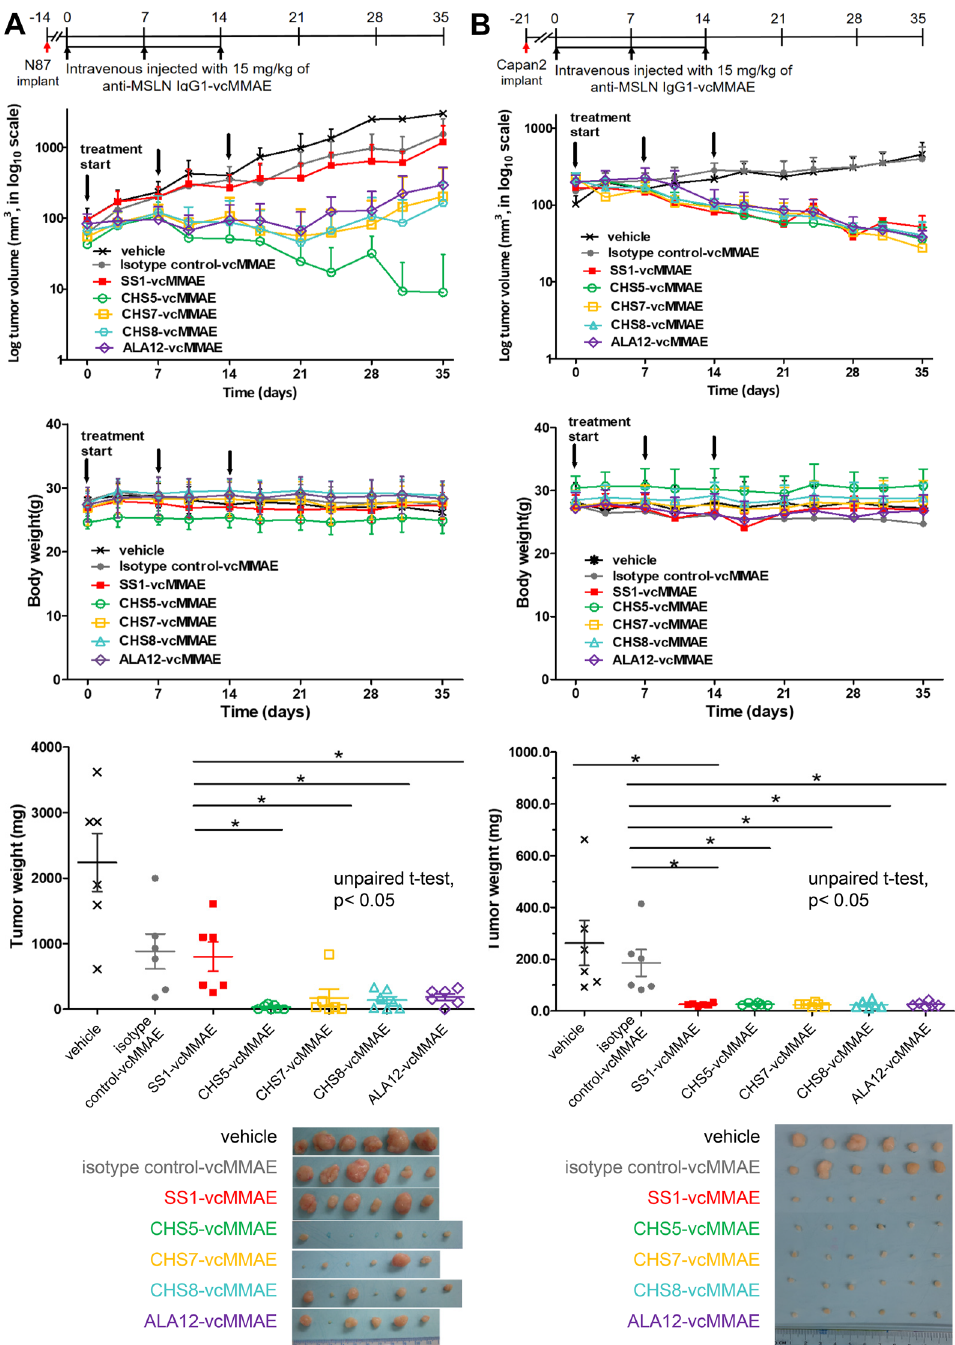
Figure 7. Treatments of N87 and Capan-2 xenograft mouse models with anti-MSLN IgG1-vcMMAEs. Four IgG1-vcMMAEs (CHS5-vcMMAE, CHS7-vcMMAE, CHS8-vcMMAE, and ALA12-vcMMAE) of the experimental ADC group were used for the in vivo treatments of the N87 ( A ) and Capan-2 ( B ) xenograft mouse models and the treatment results are compared with those of the positive ADC control (SS1-vcMMAE), isotype ADC control (S40-vcMMAE) and vehicle control. For both ( A ) and ( B ), the first panel from the top shows the treatment schedule, where the anti-MSLN IgG1-vcMMAE treatments were carried out on the xenograft mouse models randomly assigned into 7 groups (n = 6–7 per group) by treating (intravenous injection) with 15 mg/kg of respective anti-MSLN IgG1-vcMMAE at 0, 7 and 14 days. The second and the third panels from the top show the tumor volume and body weight of the xenograft mice continuously measured until day 35 post treatment. Two-tailed paired Student t-test P values indicate statistical significance (* P < 0.05). The fourth panel from the top shows the endpoint tumor weight at day 35 for each of experimental subjects plotted for each treatment group; the excised tumors used for tumor weight measurements are shown in the photographs below this